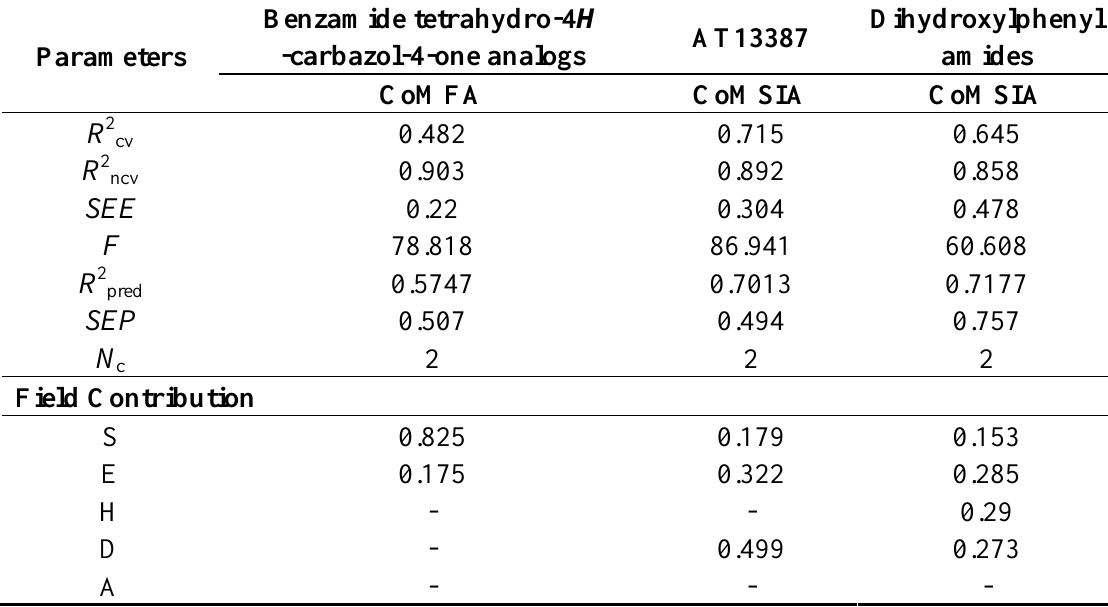
Table 1. The best results of the CoMFA and CoMSIA analyses for the training and test set compounds.